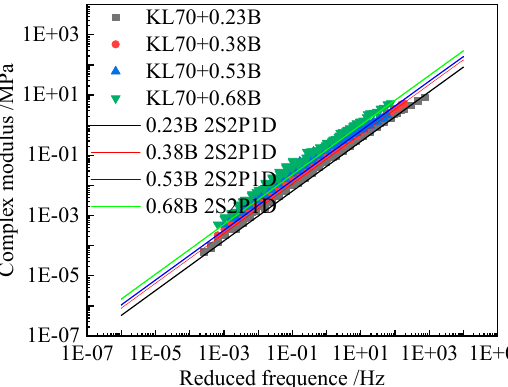
Figure 9. Comparison between the tested complex modulus master curves and 2S2P1D model fitted results of KL70 (B) asphalt mastics.